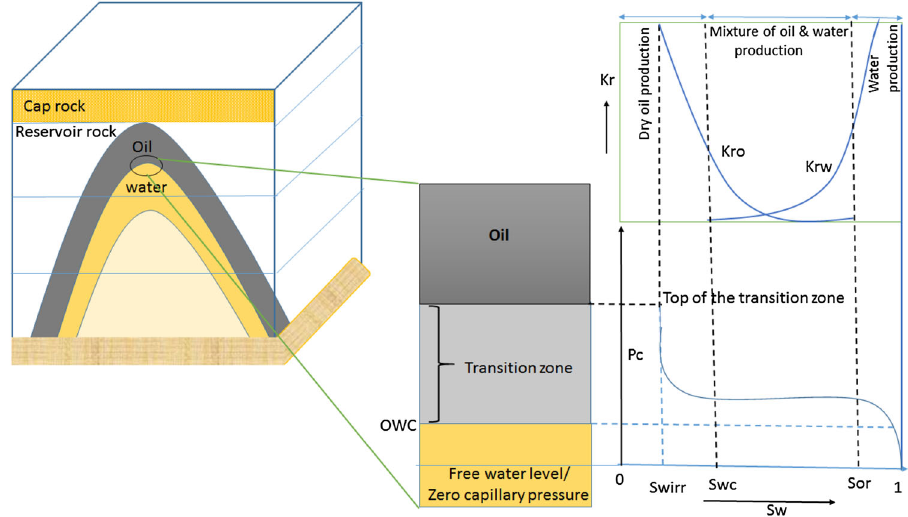
Fig. 1 Schematic diagram of transition zone description in carbonate reservoir with behaviors of capillary pressure and relative